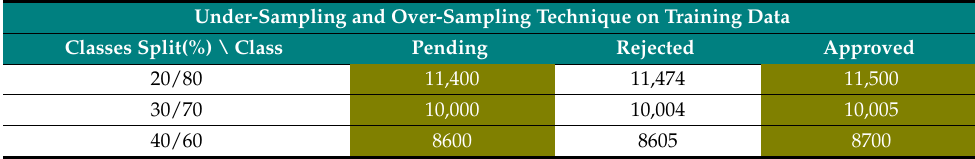
Table 4. Classes distribution after applying under-sampling on the majority class and over-sampling on the minority